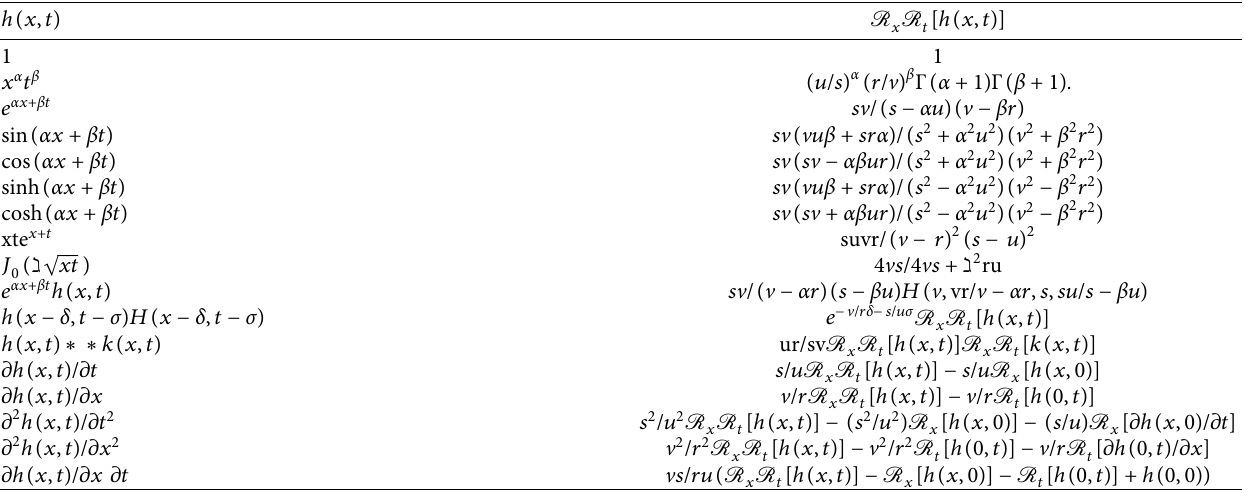
Table 1: DFT for some